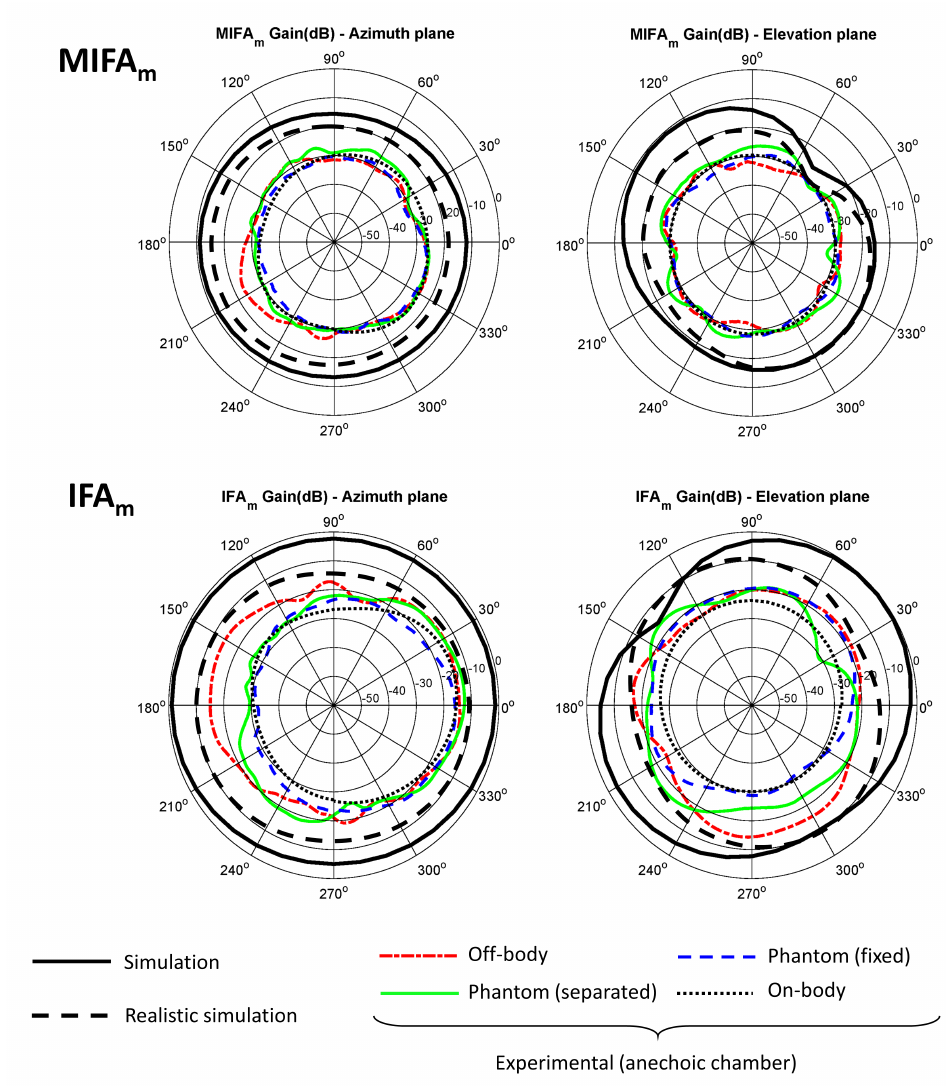
Figure 8. Simulated and experimental radiation patterns in azimuth and elevation planes of MIFA m and IFA m antennas.